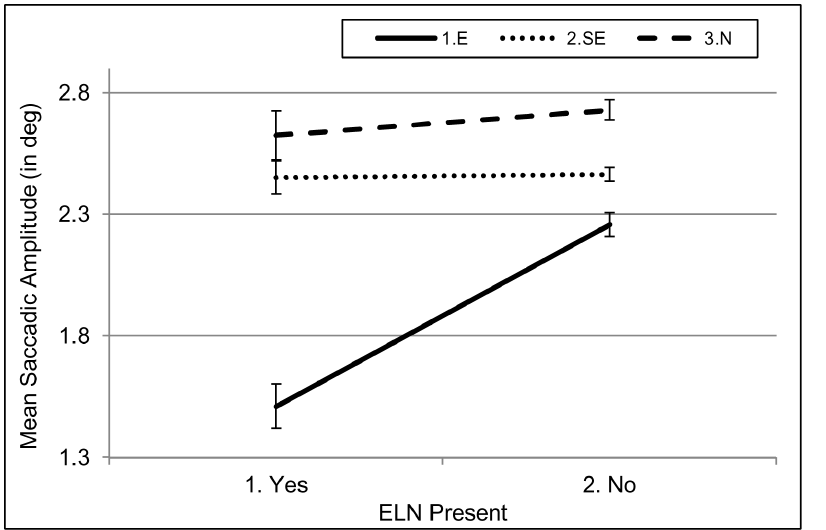
Figure 7. Interaction between Expertise and PresenceofELN for saccadic amplitude in ELN-videos. The figure depicts that unlike the other groups, experts made shorter saccades in video sections where enlarged lymph nodes were present than in sections where they were absent.